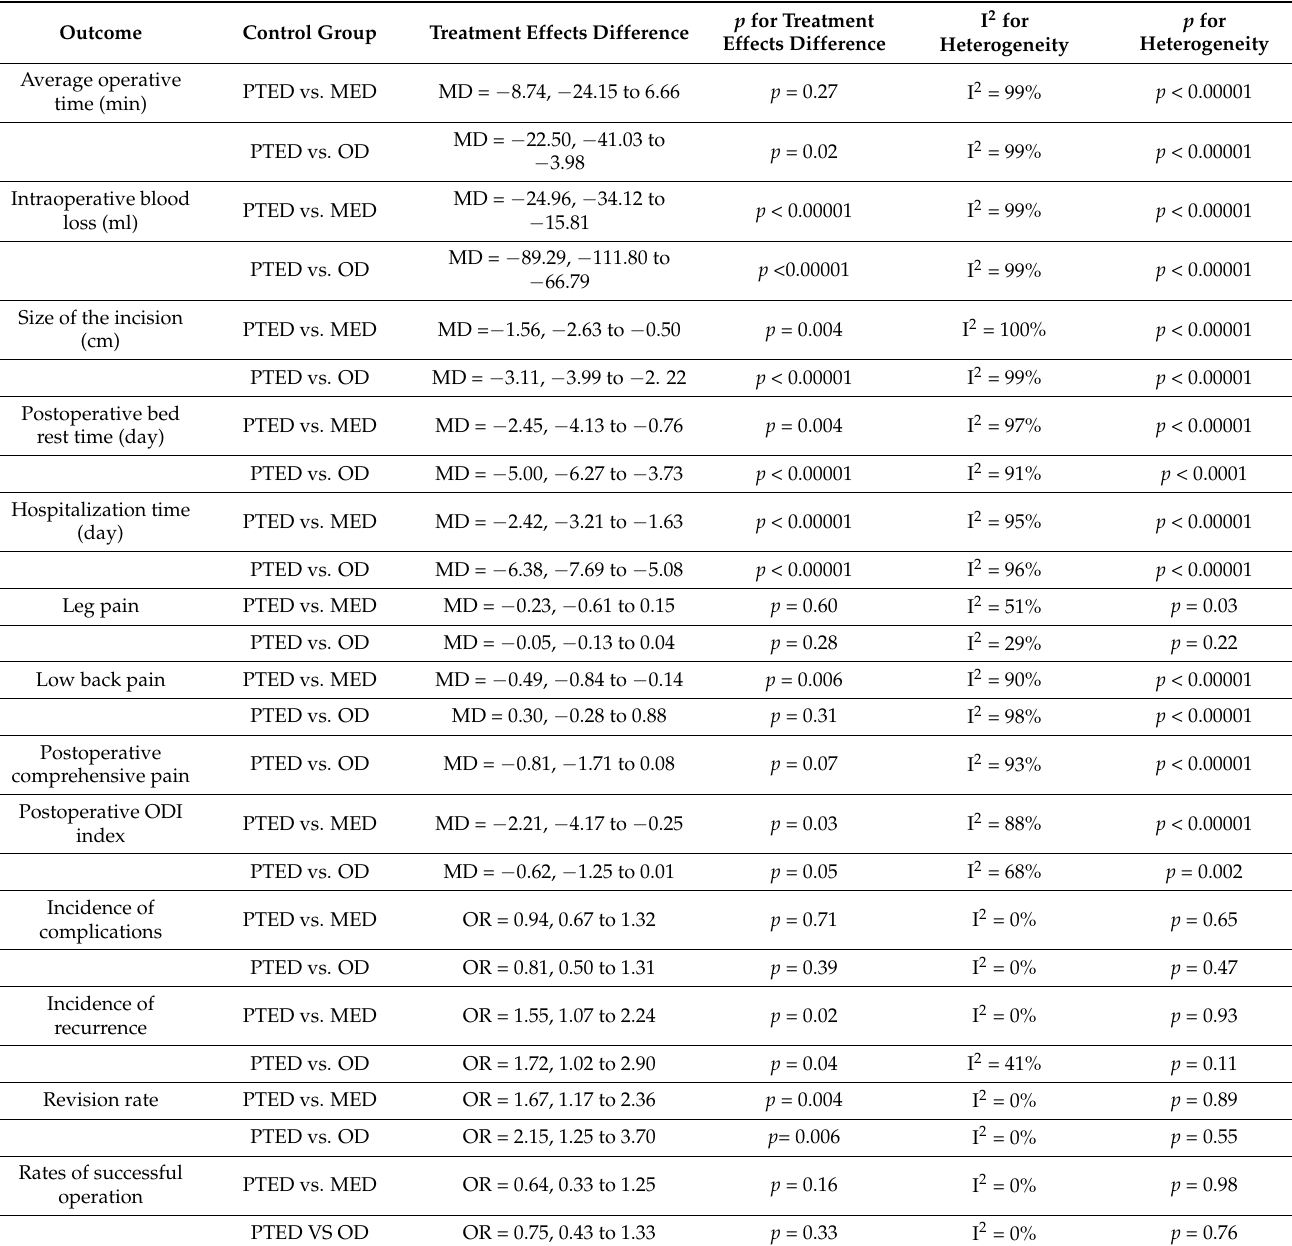
Table 4. Meta-analysis for surgical related indicators and postoperative curative